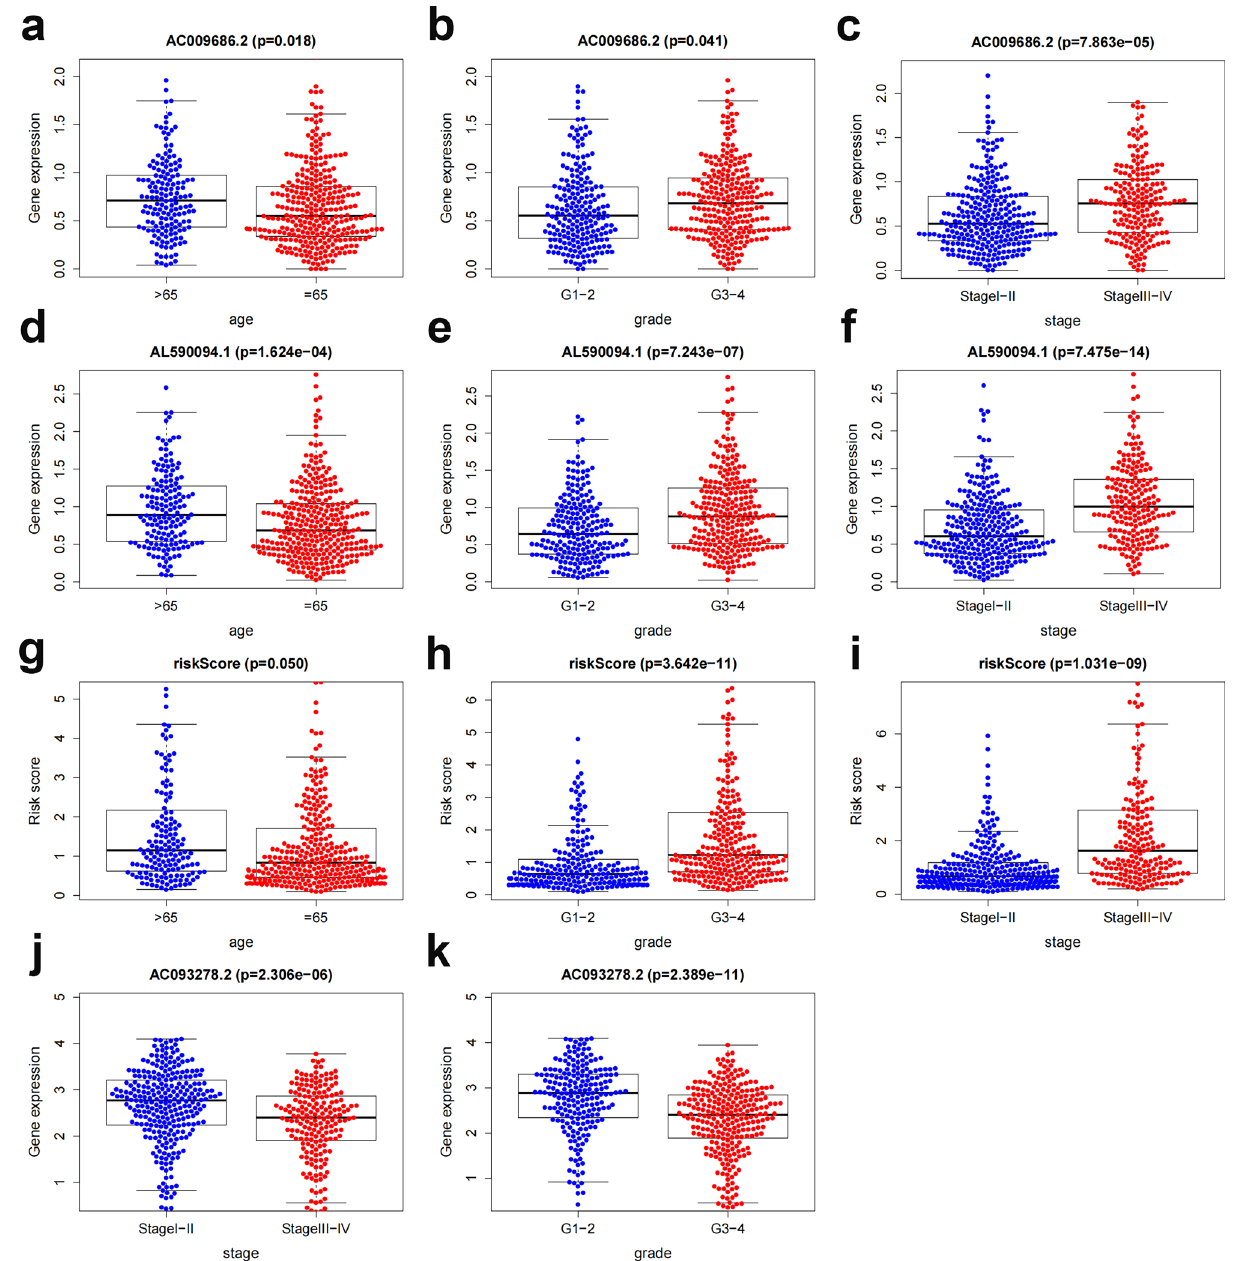
Figure 13. Correlation analysis between model genes and clinical features. ( a – c ) Correlation of AC009686.2 expression levels with age, grade, and stage. ( d – f ) Correlation of AL590094.1 expression levels with age, grade, and stage. ( g – i ) Correlation of risk score with age, grade, and stage. ( j , k ) AC093278.2 Correlation of expression level with tumor grade and